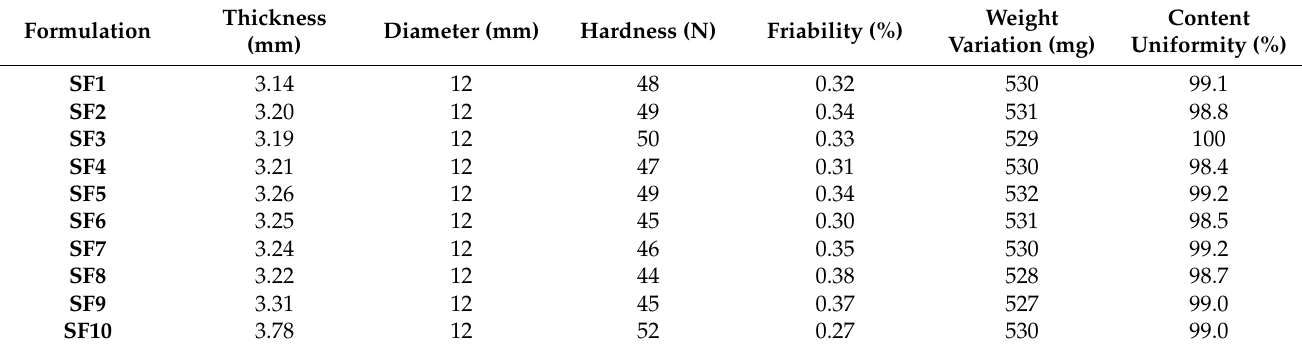
Table 2. Post-compression parameters of the